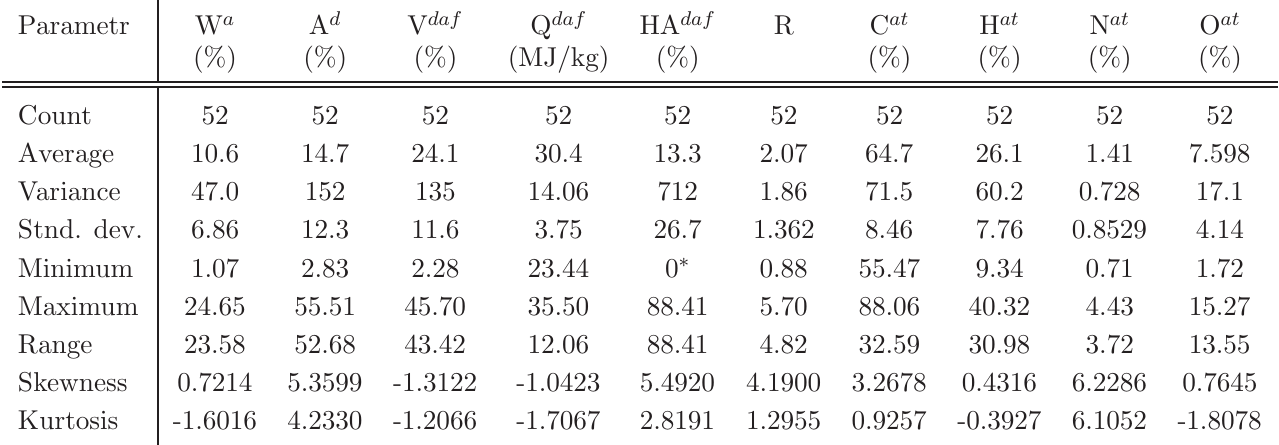
Table 1 Summary statistics of the tested geochemical